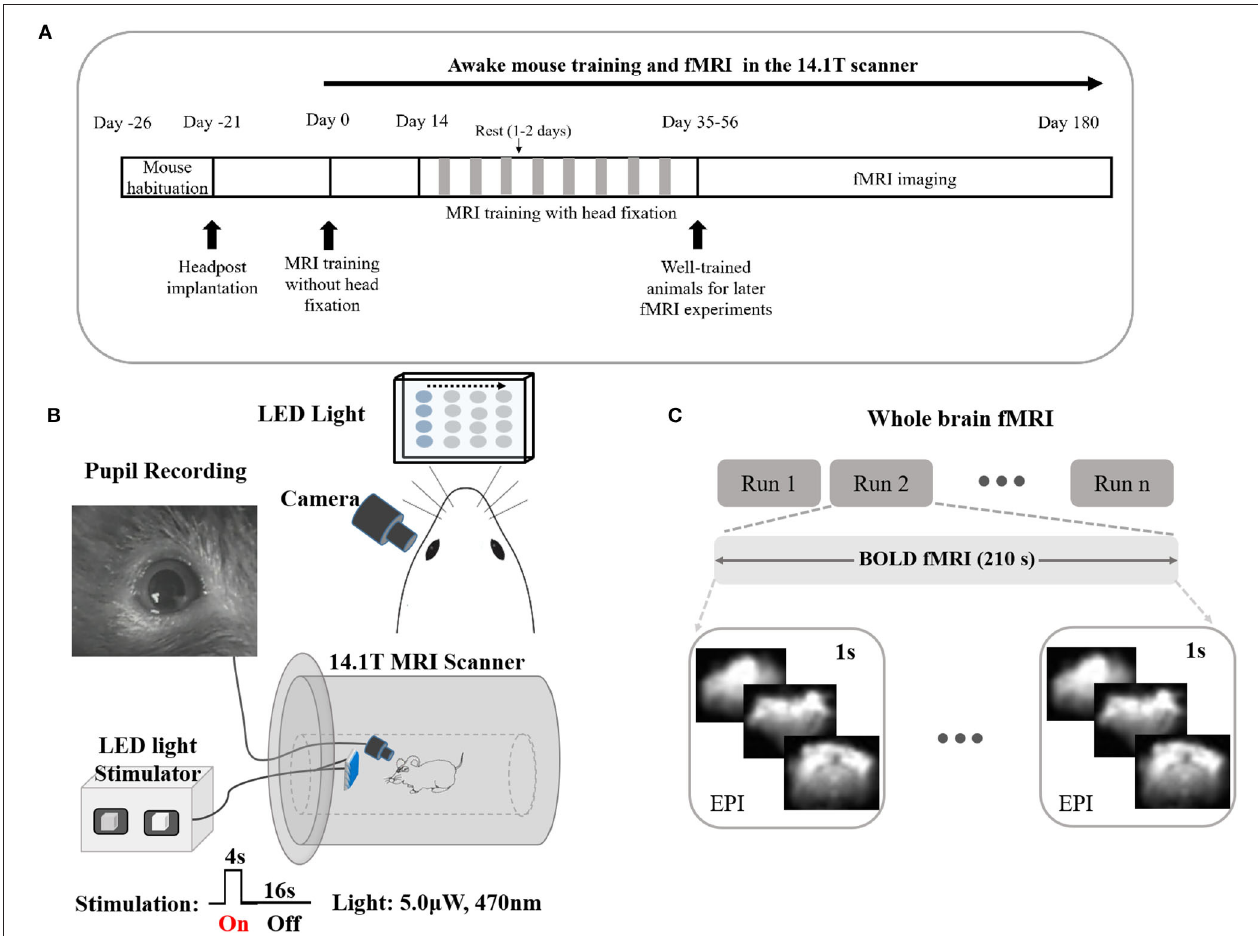
FIGURE 1 | Long training awake fMRI-pupillometry paradigm/setups in rodents without the initial use of anesthesia. (A) The intermittent restraint and training protocol. (B) Schematics of visual stimulation paradigms and pupil recordings with fMRI. (C) Designs of whole-brain fMRI modalities.